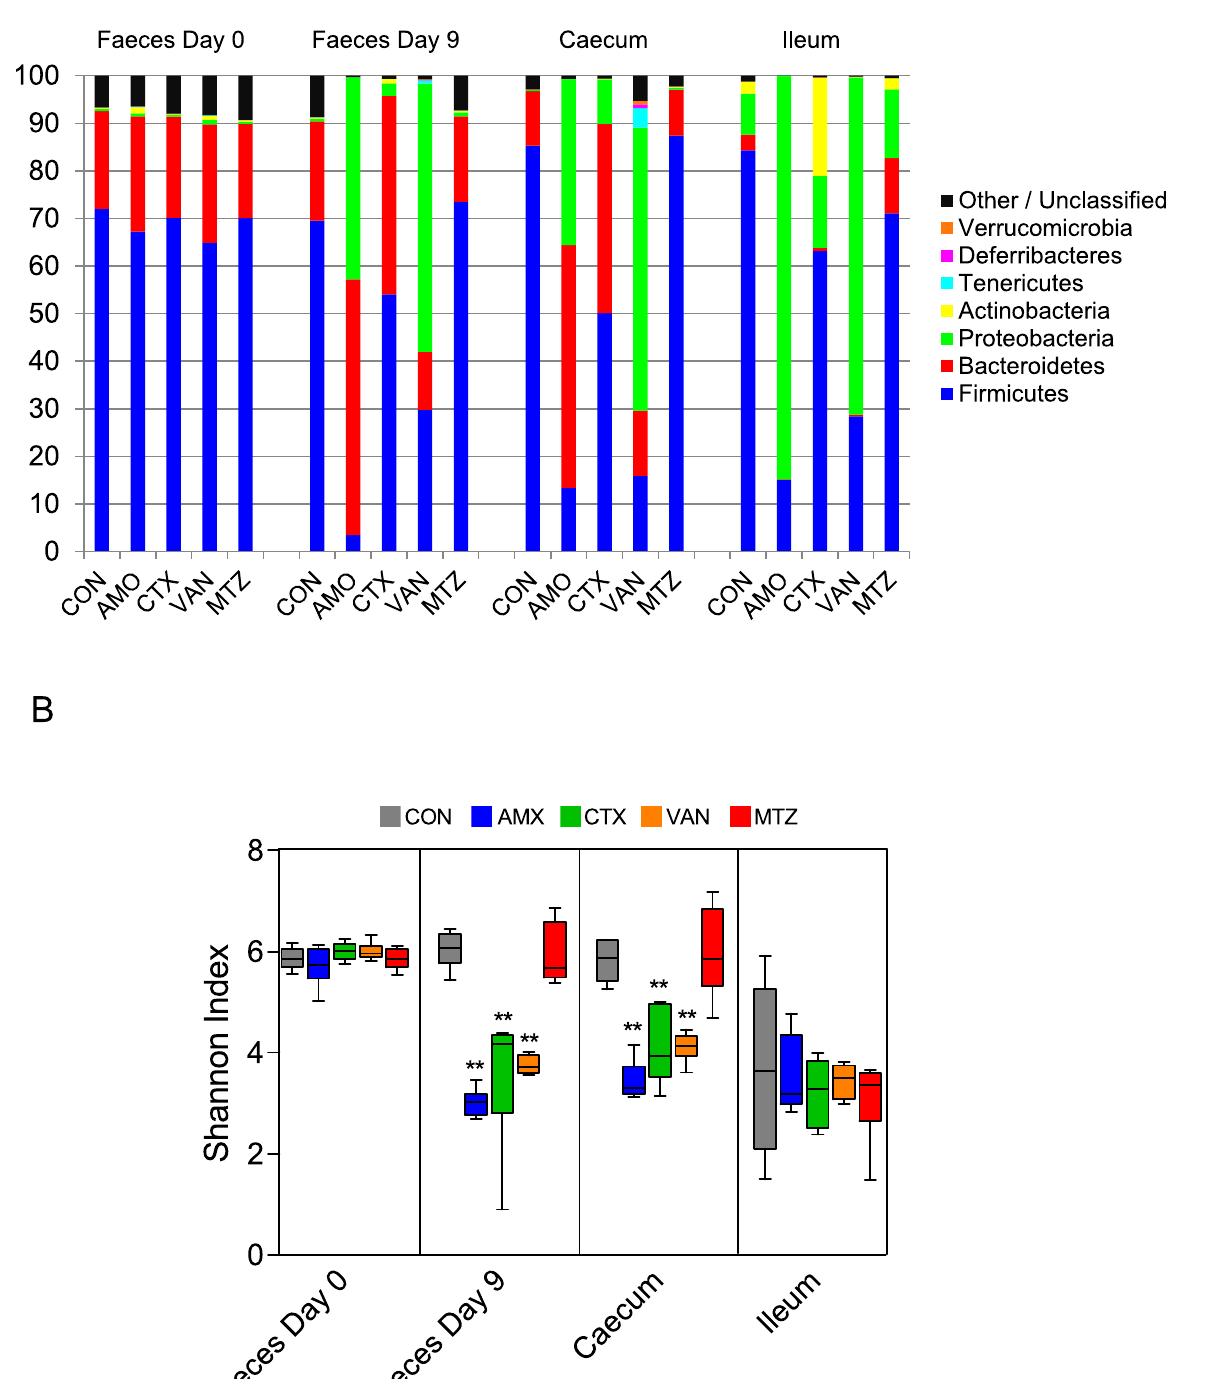
Fig 2. Bacterial community composition and Shannon diversity in faeces, caecum and ileum content based on 16S rRNA gene sequencing. (A) The average bacterial composition for each treatment group is shown at the phylum level for faecal samples (Day 0 and Day 9), caecal and ileal content. (B) Shannon diversity index determined in faecal samples (Day 0 and 9), caecal and ileal content for animal in CON, control (grey); AMX, amoxicillin (blue); CTX, cefotaxime (green); VAN, vancomycin (yellow) and MTZ, Metronidazole (red) groups. Boxplots with whisker denoting the full range are shown. Significant differences from CON group are indicated by asterisks ( * P < 0.05, ** P < 0.01).